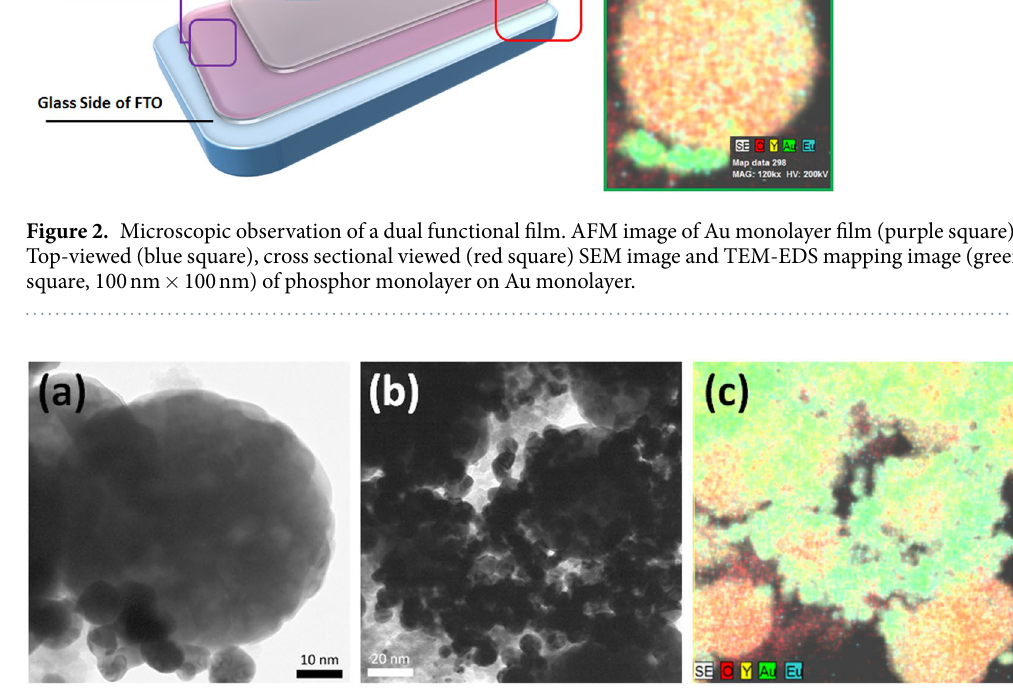
images and the SAED pattern indicate that the as-synthesized phosphor comprised spherical nanoparticles with ~100 nm diameter. HRTEM imaging proved the exact lattice position, and the lattice parameter was determined as 0.307 nm, precisely matching the (222) plane of bixbyite Y 2 O 3 :Eu 3 + (Figure S4). The XRD patterns of Y 2 O 3 :Eu 3 + phosphor nanocrystals and thin film are shown in Figure S5. The diffraction peaks of Y 2 O 3 :Eu 3 + nanoparticles were matched to the cubic phase of pristine Y 2 O 3 (PDF# 41–1105). Substitution of Y 3 + sites in the Y 2 O 3 host lat- tice by Eu 3 + ions caused the peak positions of the Y 2 O 3 :Eu 3 + phosphor particles to be slightly shifted to lower 2 θ values compared to those of the pristine cubic-phase Y 2 O 3 crystals 22, 28 . The monolayer phosphor film on the Au monolayer (Au@Y 2 O 3 :Eu 3 + layer) was fabricated by polyethylen- imine (PEI)-induced manual assembly 25, 26 . The imine groups of PEI formed covalent bonds with the oxygen atoms of phosphors on the Au surface, resulting in a monolayer of phosphor particles on the Au monolayer. As shown in Fig. 1 (b), the phosphor nanocrystals were assembled into a monolayer thin film by finger-rubbing phosphor particles on the Au monolayer. The SEM images of the fabricated phosphor monolayer in Figs 1c,d and 2 indicate that the spherical Y 2 O 3 :Eu 3 + nanocrystals were very uniformly coated on the Au monolayer film. Due to annealing at 450 °C, the phosphor nanoparticles strongly adhered to the substrate during the degradation of PEI, as shown in Figs 1d and 2. Notably, each monolayer was stacked as a hybrid-dual layer, as evidenced by cross-sectional SEM imaging with energy dispersive X-ray spectroscopy (EDX) mapping imaging (Fig. 2). TEM images and the EDX mapping image in Fig. 3 show that the Au@Y 2 O 3 :Eu 3 + hybrid double-layered thin film com- posed of the Y 2 O 3 :Eu 3 + nanoparticle layer and Au monolayers featured stable bonding of the phosphor nanocrys- tals with Au particles after thermal treatment at 450 °C. XPS chemical state analysis of the Au@Y 2 O 3 :Eu 3 + hybrid film (Fig. 4) shows that the peak at 84.0 eV was assigned to Au 4f 7/2 , while those at 156.7 and 158.7 eV were exactly consistent with the 3d 5/2 and 3d 3/2 transitions of Y 2 O 3 , respectively 29, 30 . To investigate the optical properties of the hybrid dual layer film, the Au nanoparticle and phosphor nanopar- ticle monolayer films were comparatively studied by UV-vis and PL spectroscopy, as shown in Fig. 5. The localized